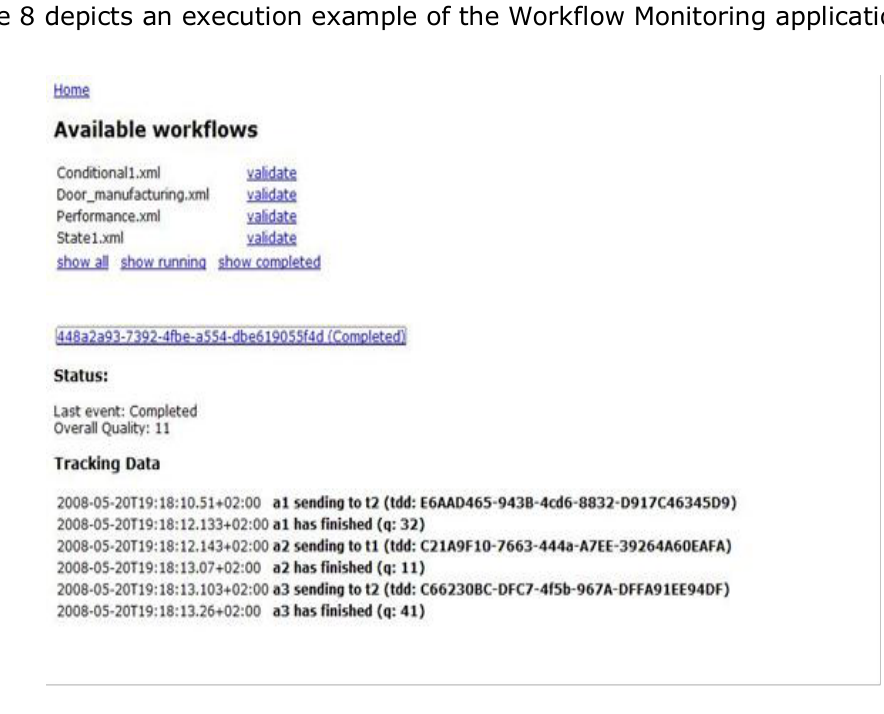
Figure 8. Example of the Workflow Monitoring